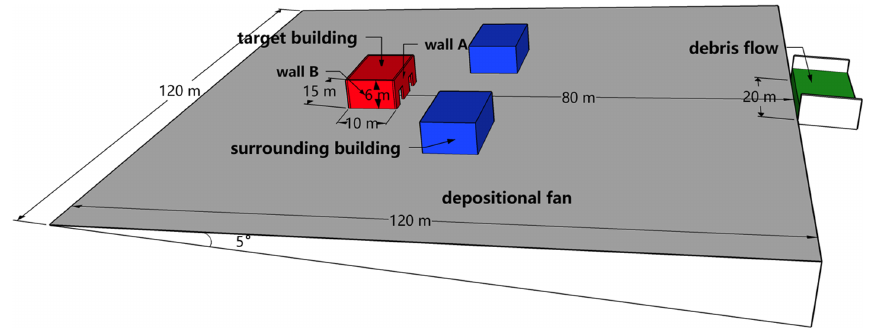
Figure 3. Overview of the components of a 3-D deposition fan model for debris flow impact simulation on